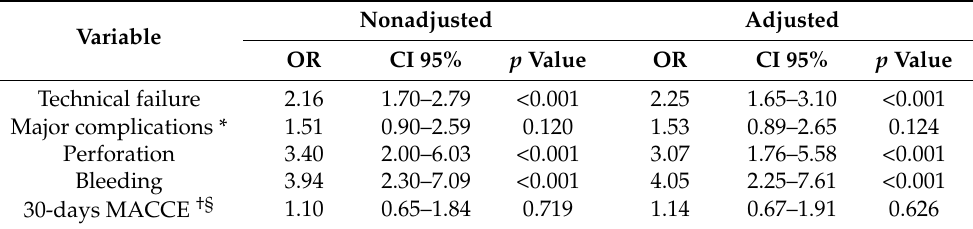
Table 6. Multivariate analysis between secondary endpoints (technical success, major complications, perforation, bleeding, 30-days MACE) and prolonged chronic occlusive (CTO) percutaneous coronary intervention (PCI) using the predefined cut-off minute value (<41.0